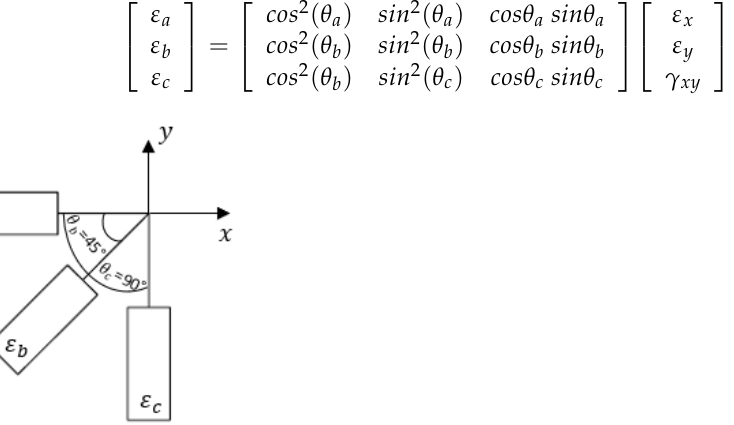
Figure 13. Illustration of the triaxial strain rosette used in this study.